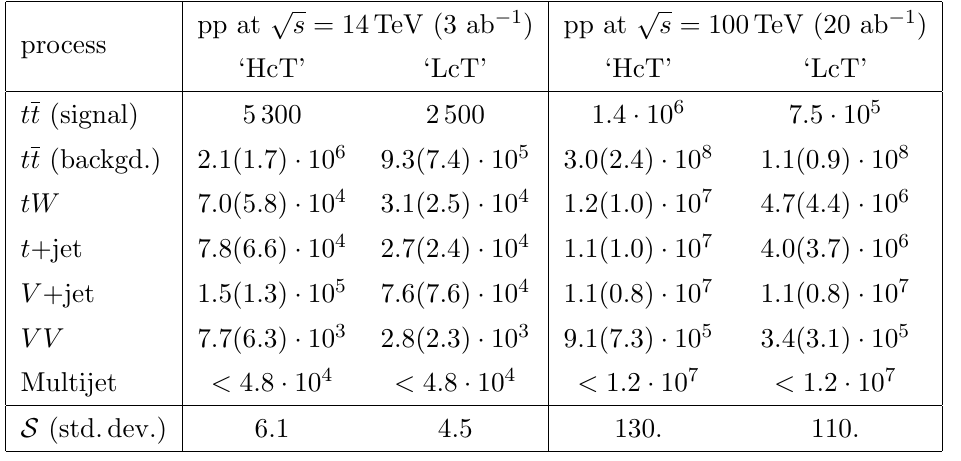
Table 11 . Total number of bottom+charm jet pairs (events, in parentheses) expected over m b;c = 120 (cid:0) 220 GeV for signal and backgrounds after all analysis cuts (see text), in lepton+jets tt (cid:12)nal p states simulated in pp collisions at s = 14 and 100 TeV, for the ‘HcT’ and ‘LcT’ charm jet reconstruction performances described in the text. The last row lists the expected signal signi(cid:12)cance S (in standard deviations) for the top-quark 2-body decay reconstructed as t ! b -jet+ c -jet. W +jets ( W + udsg , W + c , W + b ) and Z +jets ( Z + g , Z + c , Z + b ) collectively